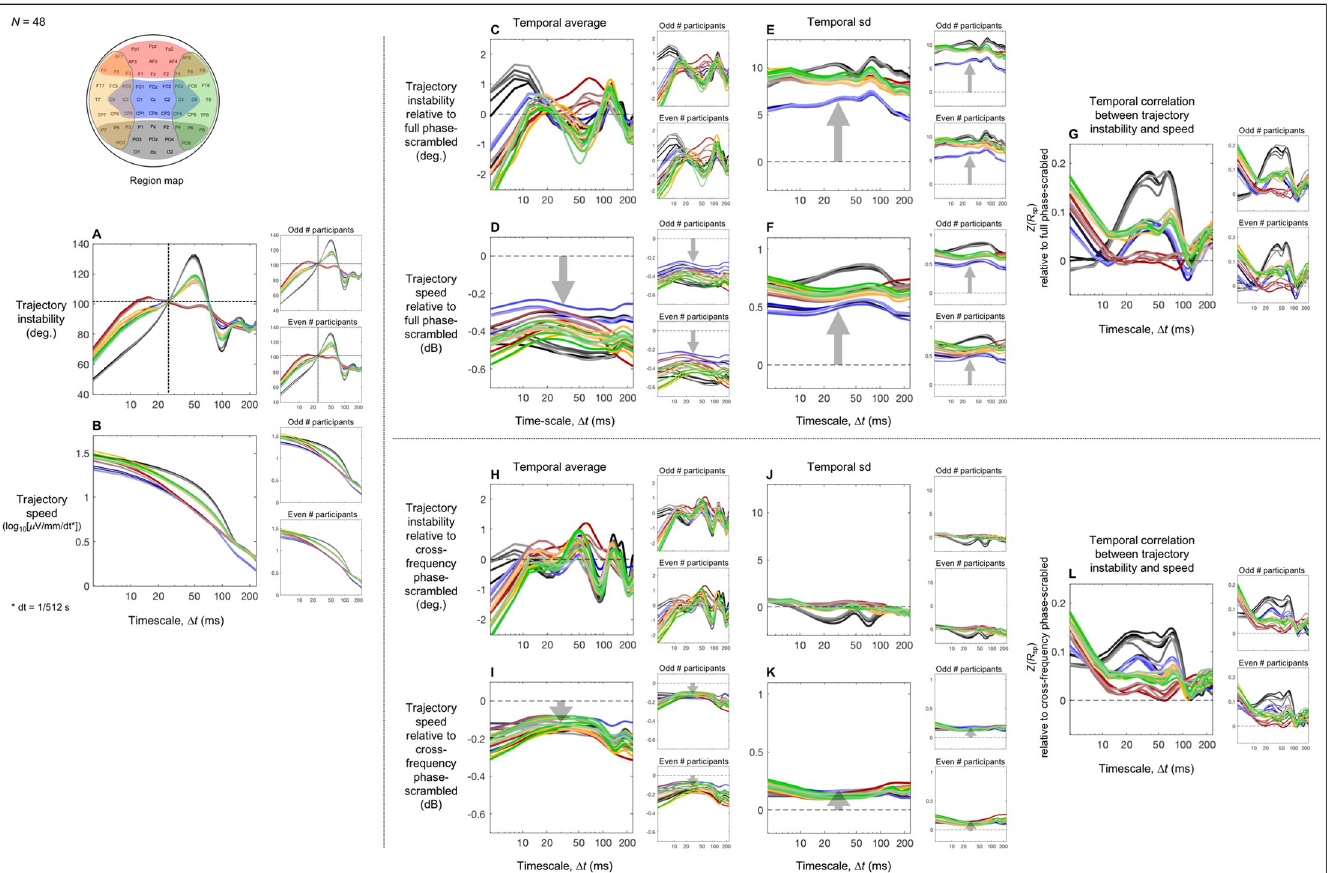
Fig 6. The results shown in Figs 3–5 re-plotted separately for successive 50-sec intervals to show the temporal stability of those results over the ~5-min period. Lighter shades indicate later intervals. A-B . Time-averaged trajectory instability and speed as a function of timescale Δ t , corresponding to Fig 3A–3F. C-G. The full- phase-relation dependent aspects of time-averaged trajectory instability and speed, their temporal variability, and their temporal correlations as a function of timescale Δ t , corresponding to Fig 4A–4E. H-L. The cross-frequency-phase-relation dependent aspects of time-averaged trajectory instability and speed, their temporal variability, and their temporal correlations as a function of timescale Δ t , corresponding to Fig 5A–5E. For each plot, the reliability of the data patterns is demonstrated by the accompanying plots on the right showing virtually identical patterns obtained from the odd and even numbered